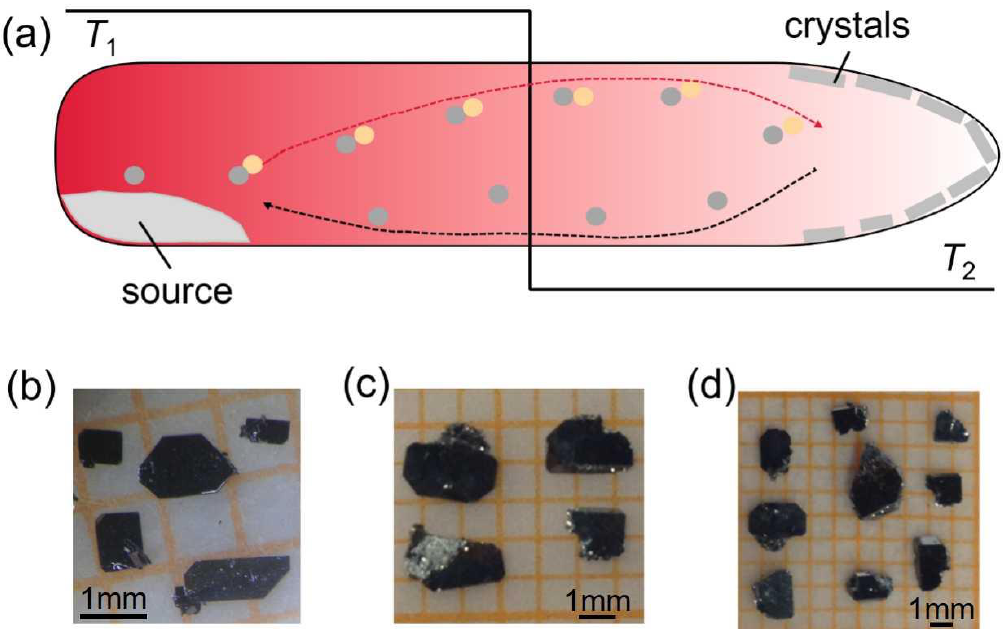
Figure 1. ( a ) Schematic illustration of a chemical vapor transport method. ( b – d ) Optical images of as-grown crystals of HfSiS, ZrGeS, and ZrGeSe, respectively.